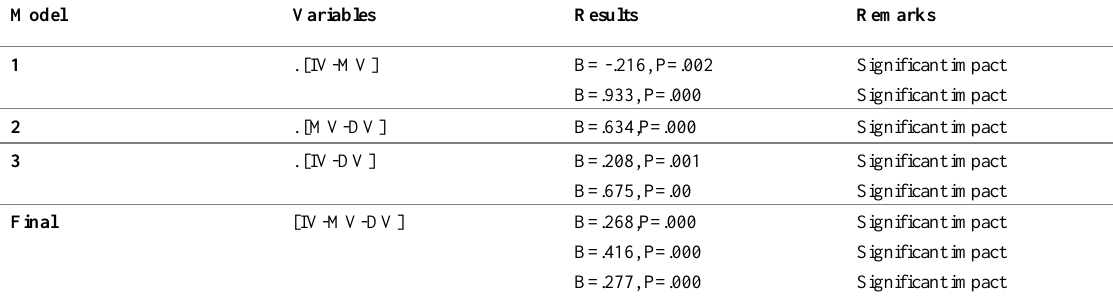
Table 4 Stepwise